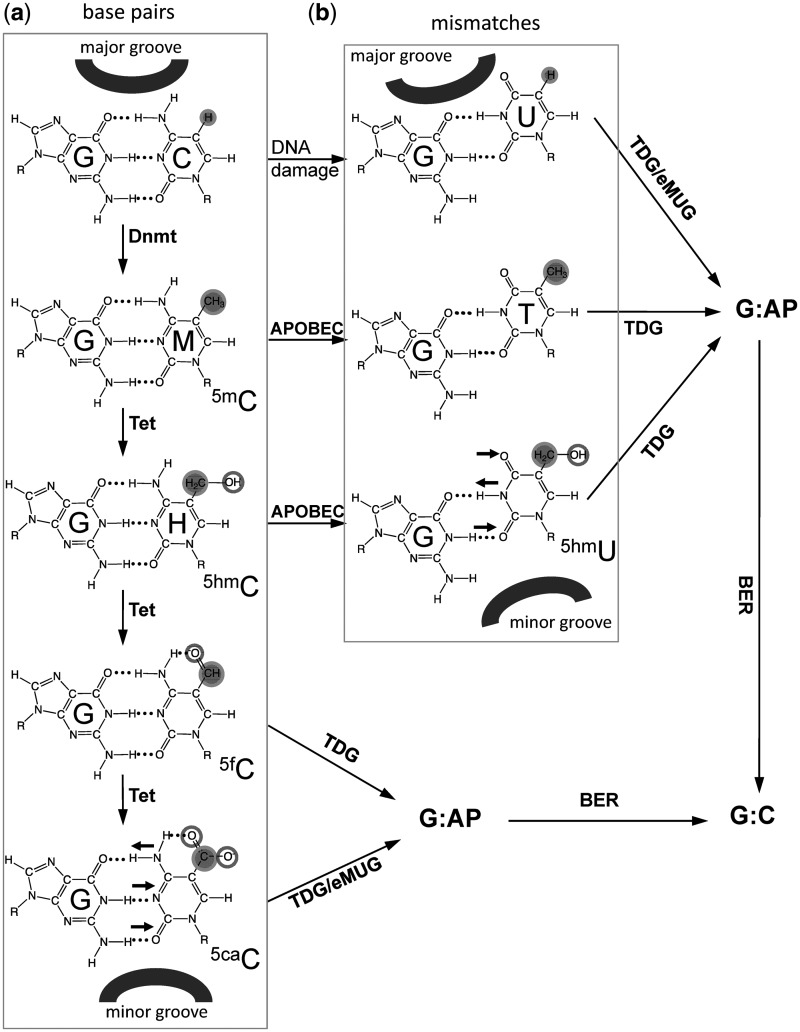
A putative pathway of DNA demethylation involving DNA methylation by DNMTs, hydroxylation by Tet proteins, deamination by members of APOBEC superfamily, and base excision by TDG linked to base excision repair (BER). In addition, eMUG can excise 5caC as well (see Figure 2). DNA major groove and minor groove sides are indicated. Horizontal small arrows indicate the hydrogen bond donors and acceptors for 5caC and 5hmU bases. (a) C, 5mC and its oxidized derivatives (5hmC, 5fC and 5caC) form base pairs with an opposite G. (b) Deamination-linked mismatches.